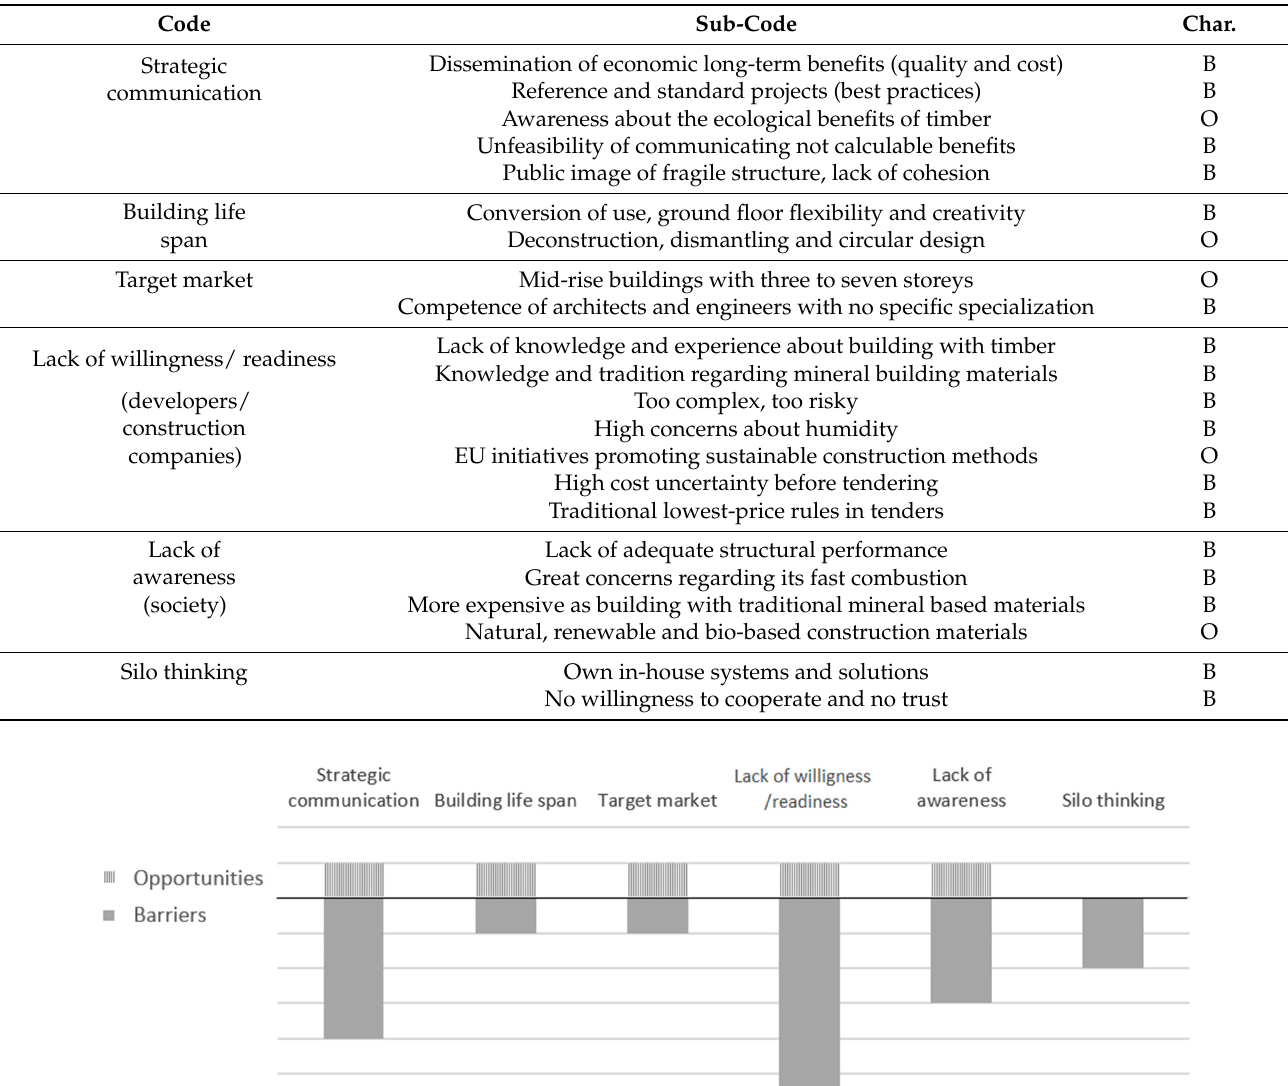
Table 4. Summary of codes in category Acquisition with their embedded sub-codes and character according to their frequency of nomination.